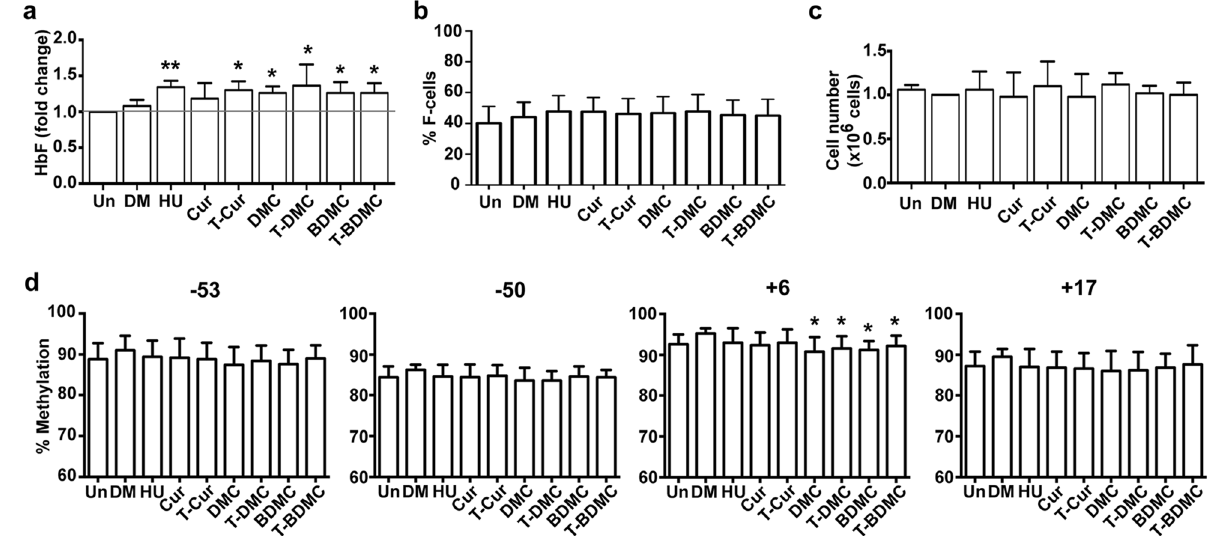
Figure 4. Curcuminoids and their trienone analogs induce HbF synthesis in β-thalassemia/HbE erythroid progenitor cells. The erythroid precursor cells were treated on day 7 of culture and harvested on day 11 for determination of HbF by immunostaining with FITC-conjugated anti-HbF and analyzed by flow cytometry. Analysis of fold change of ( a ) HbF, ( b ) % F-cells and ( c ) cell number of β-thalassemia/HbE erythroid progenitors were compared to untreated cells. Increased HbF in the compounds treated cells compared with DMSO treated cells was observed without significant reduction in cell number compared with untreated cells. ( d ) DNA methylation at CpG − 53, − 50, + 6 and + 17 of the G γ-globin promoter region were determined by bisulfite conversion and pyrosequencing. Decreases DNA methylation at CpG + 6 in treated cells was observed. HU (100 μM) was used as positive control. DMSO (0.25%) was used as negative control. The data were shown as mean ± SD from five β-thalassemia/HbE patients (n = 5). *,**, statistical significance when compared to DMSO treated cells at P < 0.05 and P < 0.01,